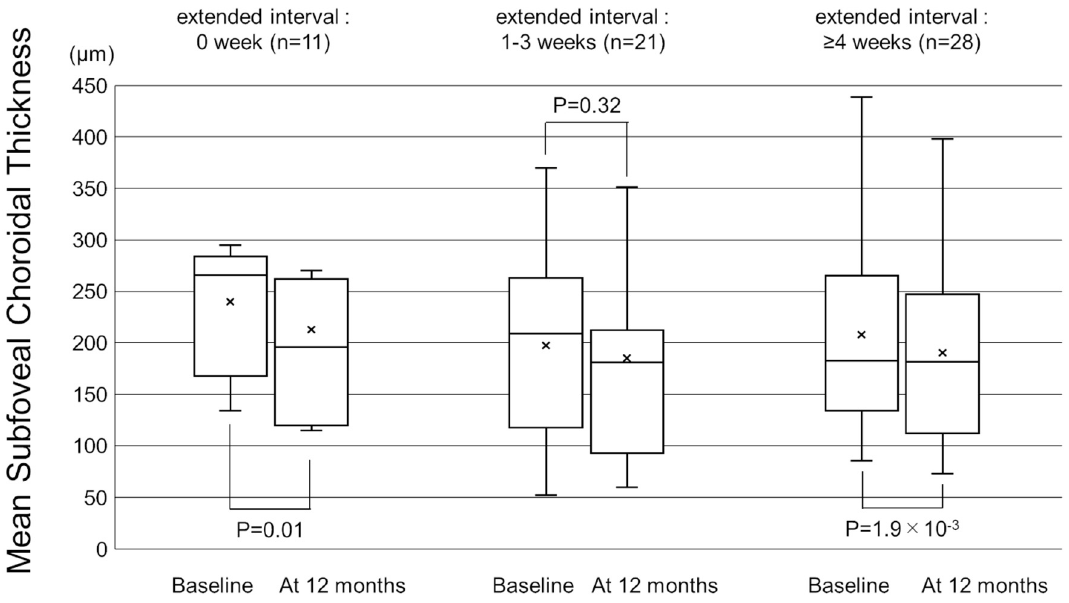
Figure 5. Box-and-whisker plot of mean and median subfoveal choroidal thickness (SCT) on swept- source optical coherence tomography (SS-OCT) before and after switching to brolucizumab accord- ing to the extended treatment intervals. The “x” marks in the boxes indicate the mean SCT. The horizontal lines in the boxes indicate the median SCT, and the top/bottom edges of the boxes